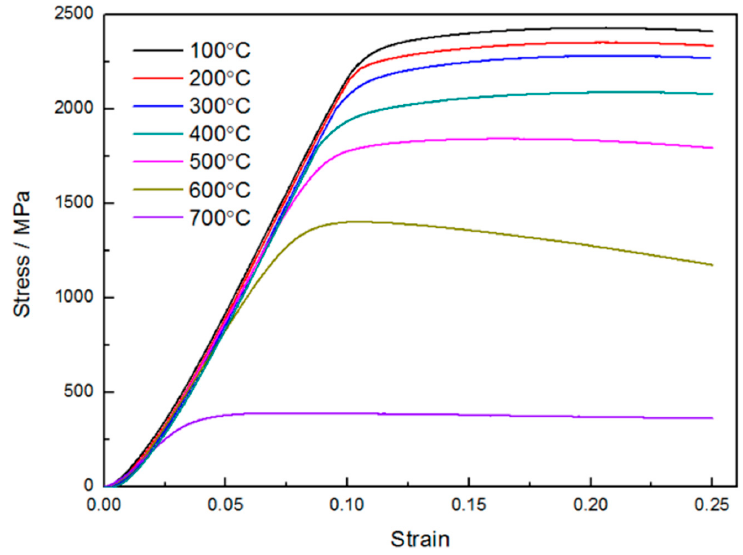
Figure 5. Stress-strain curve of H13 steel at high temperature.